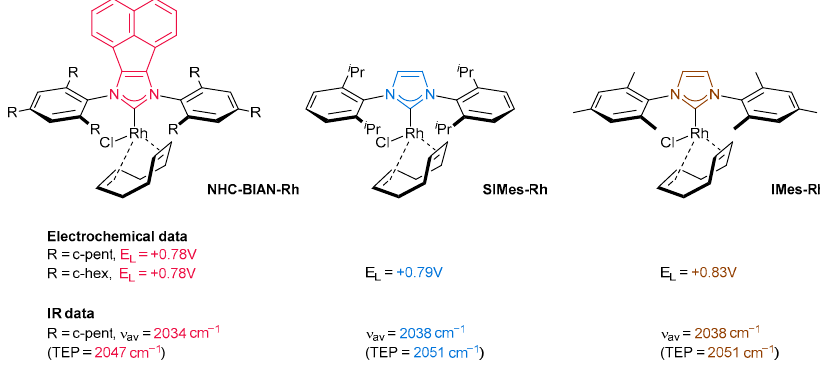
Figure 2. Comparison of the electronic properties of NHC ligands with NHC-BIAN-type